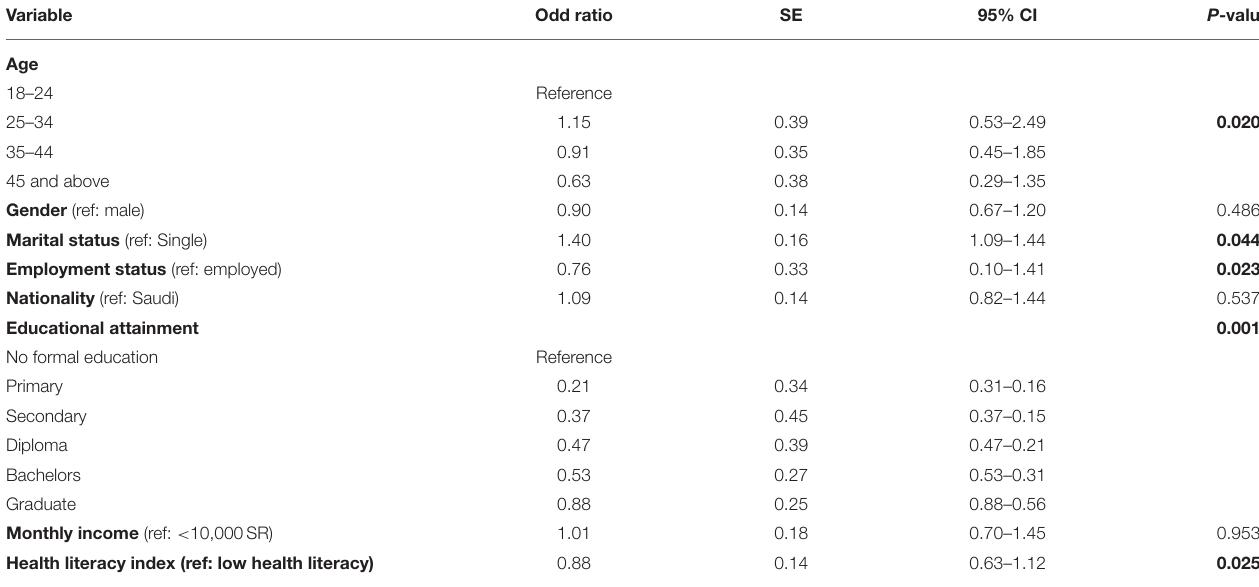
TABLE 3 | Predictors of the fear of COVID-19 identified by multivariable logistic regression